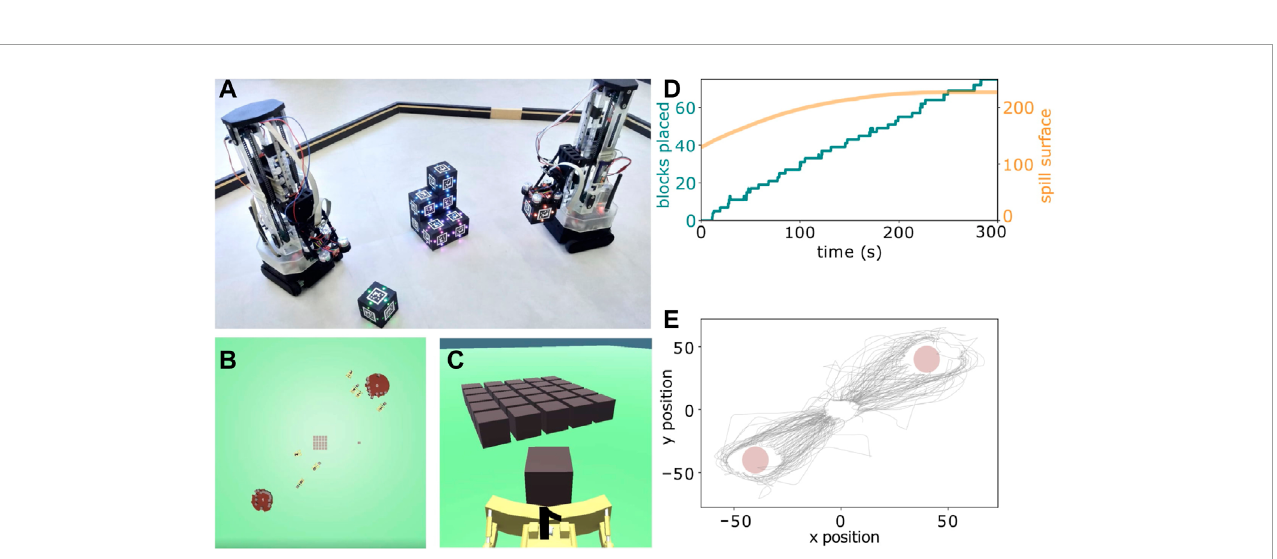
FIGURE 2 Collective construction. (A) Two physical robots that perform collective construction using stigmergic blocks (Allwright et al., 2019). Figure (A) reprinted from Allwright et al. (2019) under license CC BY-NC-ND 4.0. (B, C) “Lava spill task” in which participants use indirect communication to collectively construct a barrier to contain expanding spills. (D) The spill size stagnates after around 200 s, when participants successfully enclosed it with construction blocks. (E) Data such as the avatar trajectories can be used to analyze how participants coordinate the placement of blocks. Figures (B–D) adapted from Coucke et al. (2021) under license CC BY